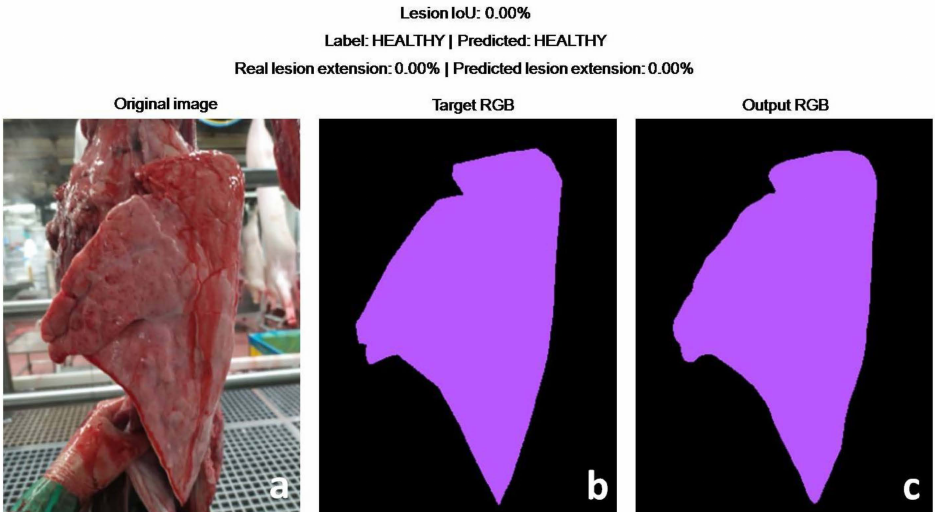
Figure 8. Test set. Healthy lung. Pictures ( a , b ) represent the original picture and the annotation of the veterinarian, respectively. In this case, the veterinarian annotated only the lung (purple).The prediction of the DLBM ( c ) perfectly matches the annotation of the veterinarian ( b ). The examination of the original picture ( a ) confirms that the lung is healthy, no lesion being detectable.